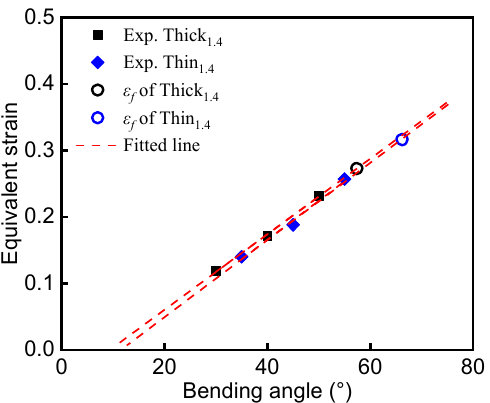
Figure 8. Equivalent strain calculated with the methodology as a function of the loaded bending angle α L for the 1.4 mm Al–Si-coated steel.